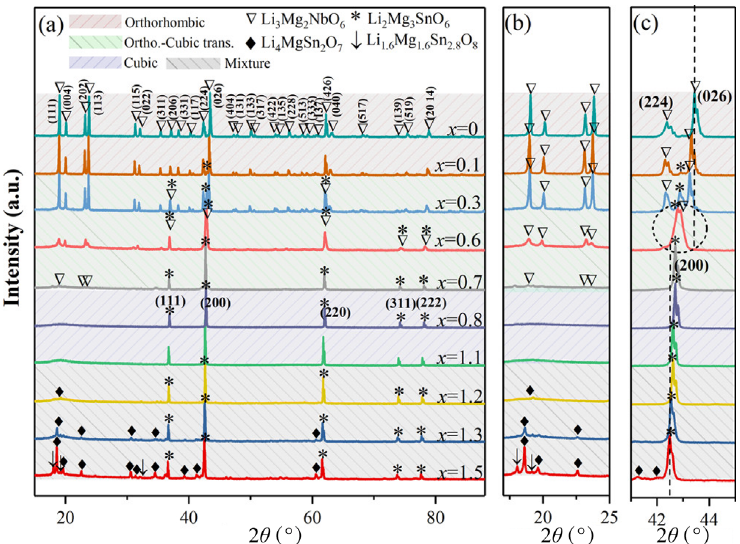
Fig. 12 (a) XRD patterns of Li 3 Mg 2– x /3 Sn x Nb 1–2 x /3 O 6 ( x = 0–1.5) MWDCs sintered at 1290 for 4 h. (b) Amplified spectra of